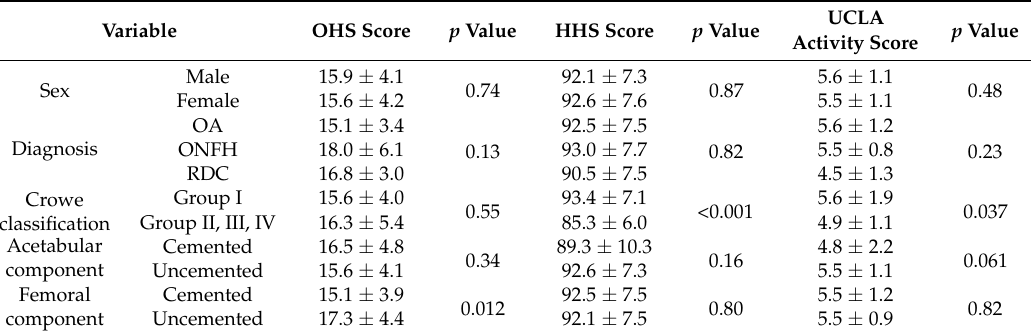
Table 5. Clinical scores 6 months after total hip